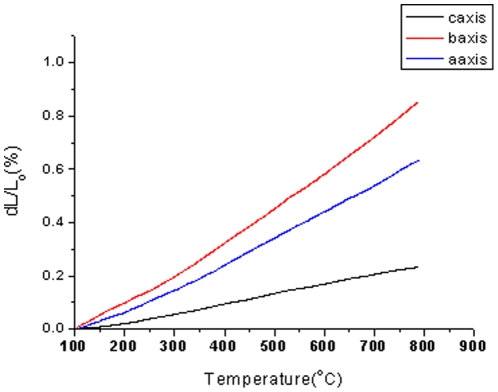
Thermal expansion of Cr3+∶ MgMoO4 crystal.